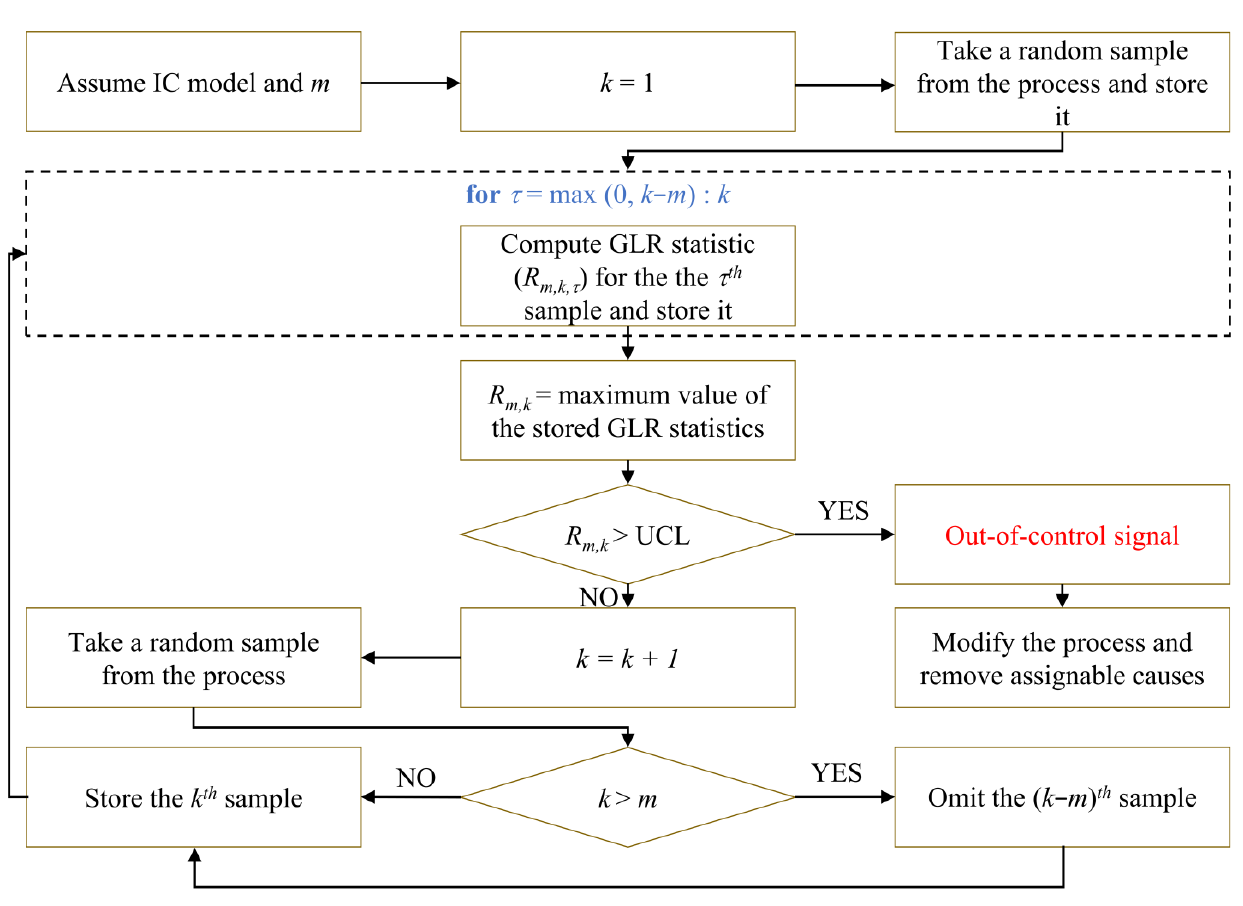
Figure 1. The procedure of GLR statistic computations.